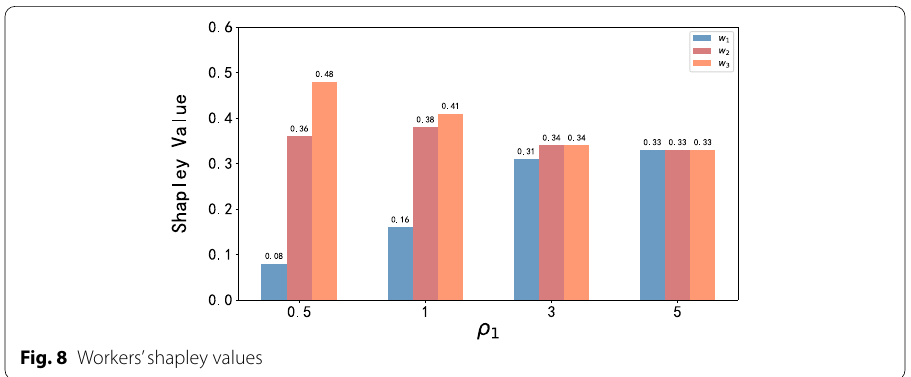
Fig. 8 Workers’ shapley